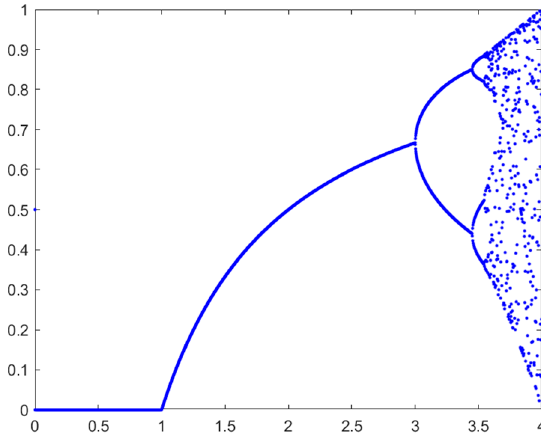
Figure 3. Logistic mapping bifurcation diagram [31].